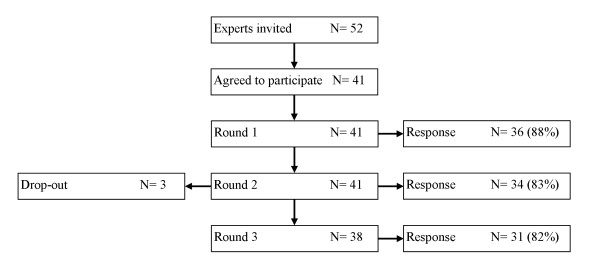
Flowchart of panel member participation.